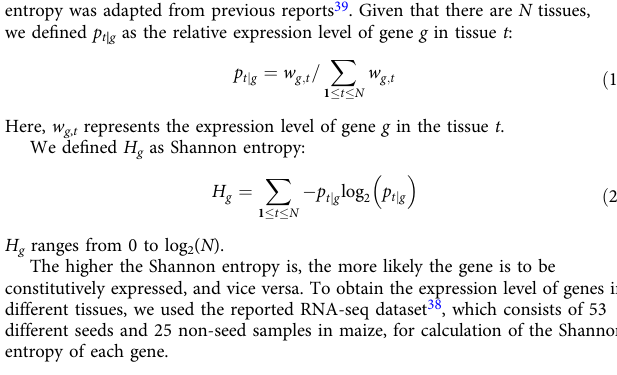
Supplementary Table 6. The source data underlying Figs 1d, 4a, b, 5d, e, and 7d and Supplementary Figs 4 – 6, 10a and 10b are provided as a Source Data fi